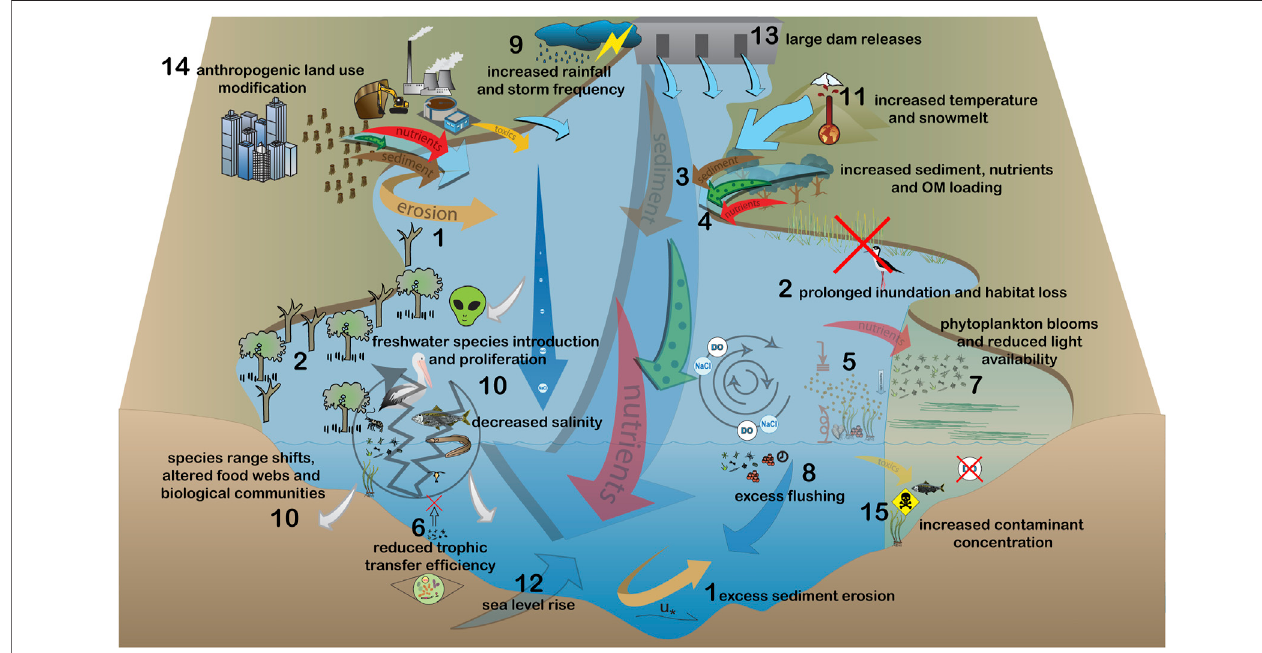
FIGURE 2 | Modi fi ed estuarine ecosystem processes under long-term increases in fl ow and/or increases in the frequency and magnitude of large fl ow events. Impacts of this fl ow scenario are: 1) excess sediment erosion, 2) prolonged inundation of intertidal habitat, 3) increased sediment and 4) organic matter and nutrient loading, 5) reduced light availability and excess sediment impacts on benthic fauna, 6) reduced trophic transfer ef fi ciency 7) algal bloom formation and associated water qualitydecline,8)excess fl ushing,10)decreasingsalinitythroughouttheestuaryandassociatedchangestospeciesdistribution,and15)bioaccumulationoftoxins in organisms. Principal drivers of change are: 9) increased rainfall and frequency and magnitude of storms, 11) increased snow melt, 12) sea level rise, 13) large dam releases and 14) anthropogenic land use modi fi